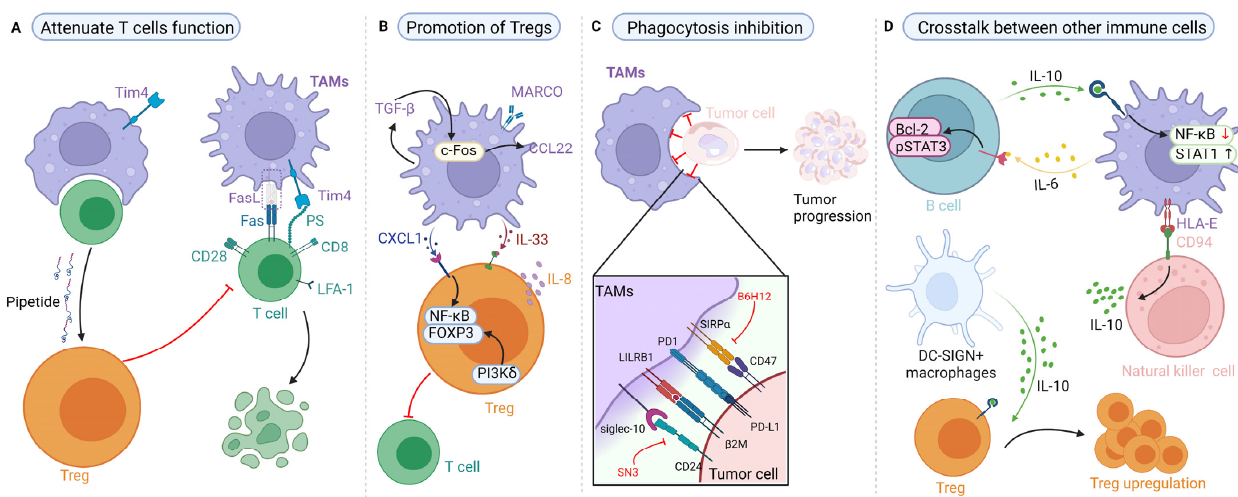
Figure 3. Targeting the crosstalk between TAMs and immune cells. ( A ) Tim4 and fasL expressed on the surface of TAMs could bind with phosphatidylserine and Fas on T cells, respectively, then in- ducing the apoptosis of T cells and suppressing the function of T cells. Apoptotic T cells could be phagocyted by TAMs, subsequently releasing pipetide to activate Treg, as a result, inhibiting the function of T cells. ( B ) TAM-derived chemokines and cytokines, such as TGF- β , CCL22, CXCL1, and IL-33, could upregulate the activity of Treg via the NF- κ B and PI3K δ signaling pathways, then sup-